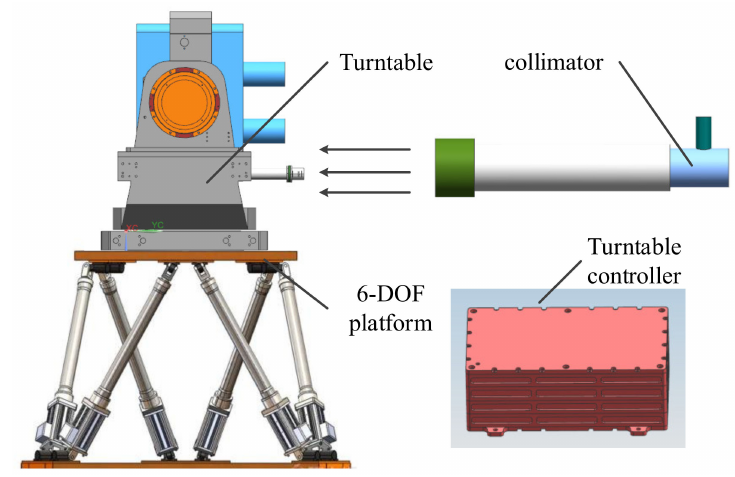
Figure 9. Test environment for sun tracking.